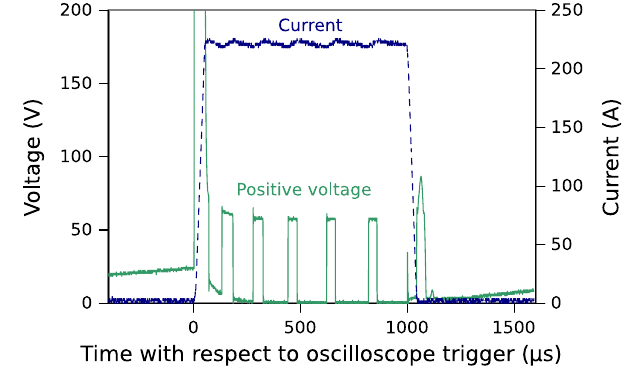
15. Measured flat top of current pulse at an operating current of 193 A. Blue dashed trace: current (ac-coupled measurement with an offset of 193 A added to the average value). Green solid trace: output voltage of low-voltage power supply stage to maintain flat-top